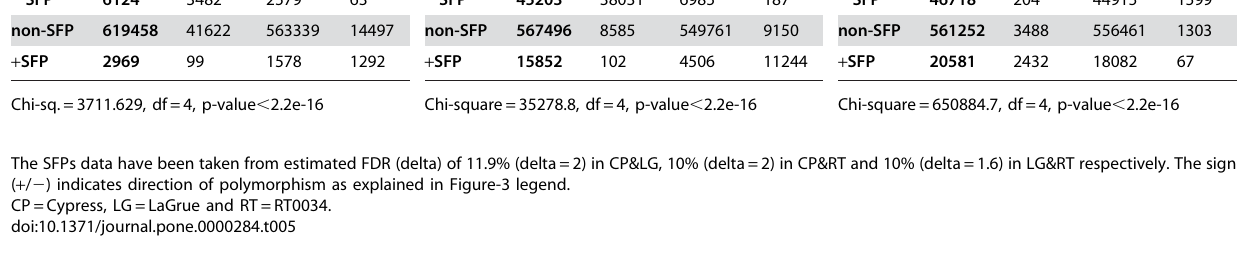
The higher number of common SFPs in gene-chip predicted SFPs of japonica&indica datasets combination (Table 5b) may be due to indica variety (RT) was common in both the datasets and secondly genetic divergence between two japonica varieties viz. CP and LG were low as evidenced by their frequency of polymorphisms (Table 2). From common polymorphisms data of gene-chip vs. in- silico SFPs comparison study of japonica&indica datasets combi- nations (Table 6b&c), we estimated further the frequency of overlapping SFPs by comparing their common SFPs. The analyses showed that 80–85% of SFPs were still common (Table 6d) in the three different japonica&indica datasets and also there wasn’t any overlap with regards to polymorphism directions. This finding also